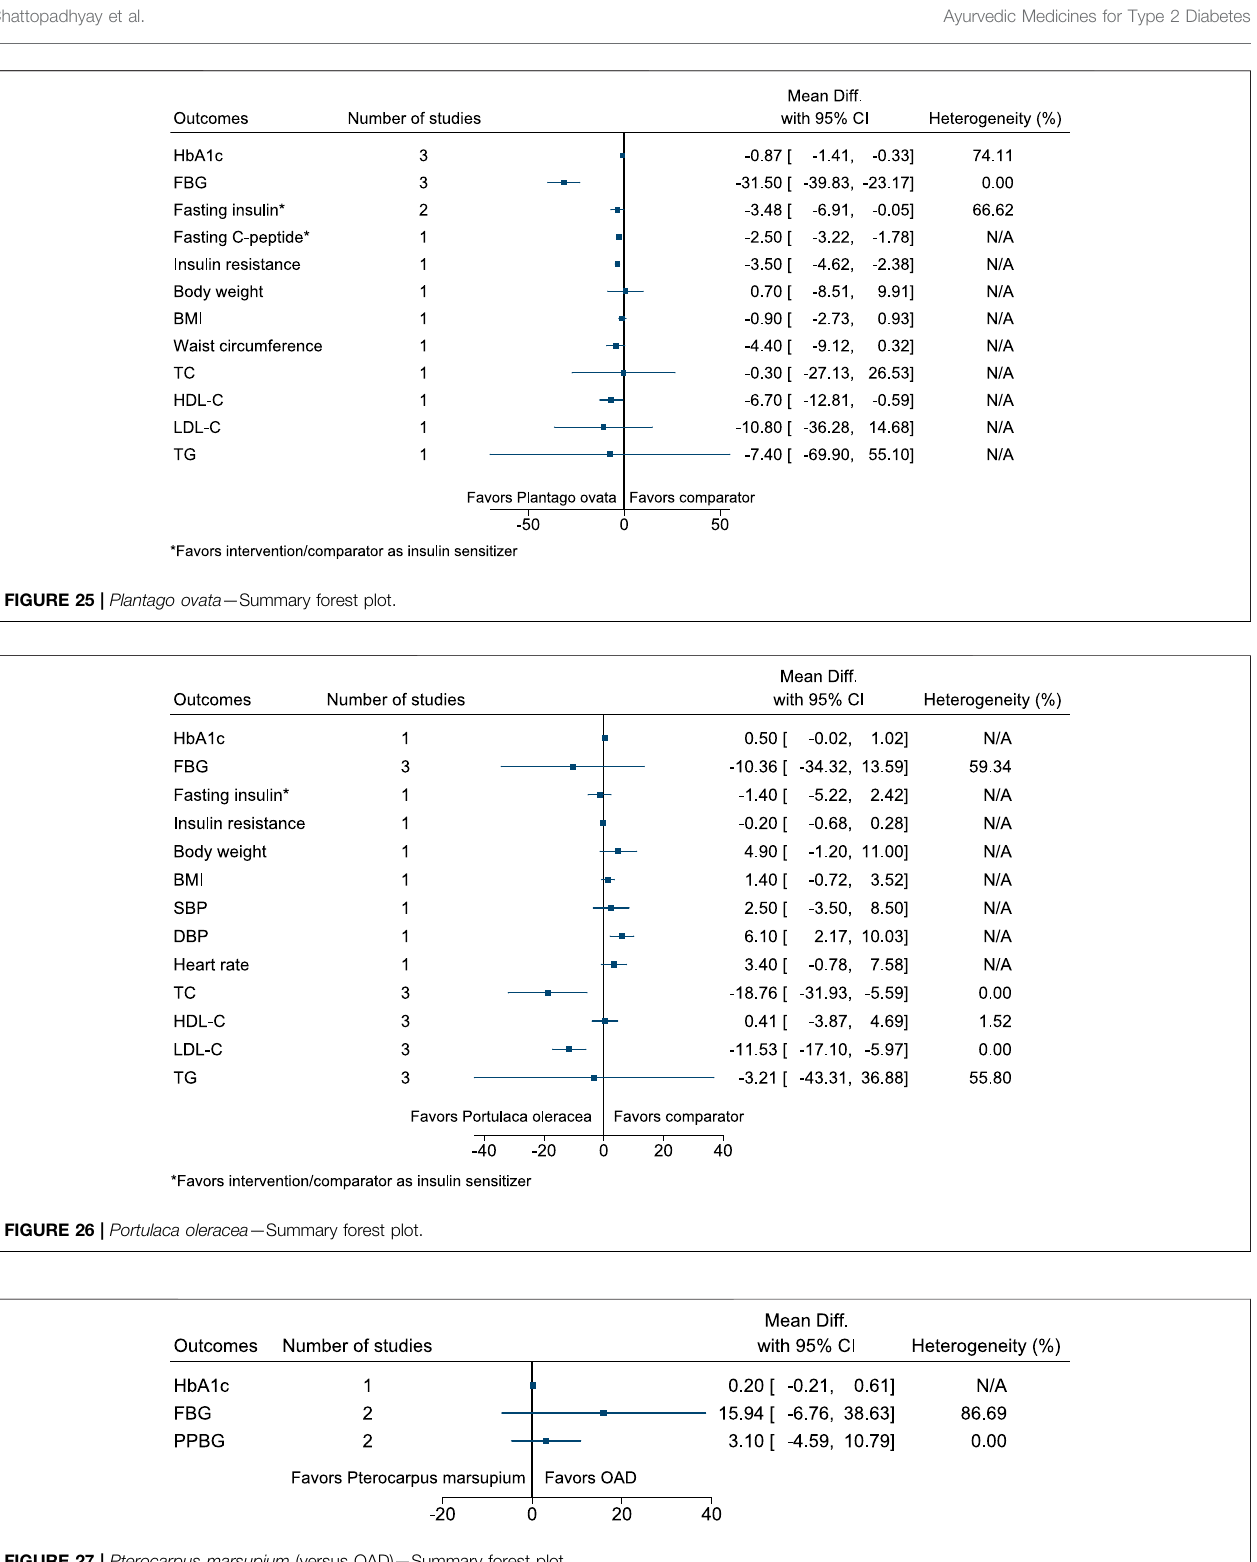
Frontiers in Pharmacology |